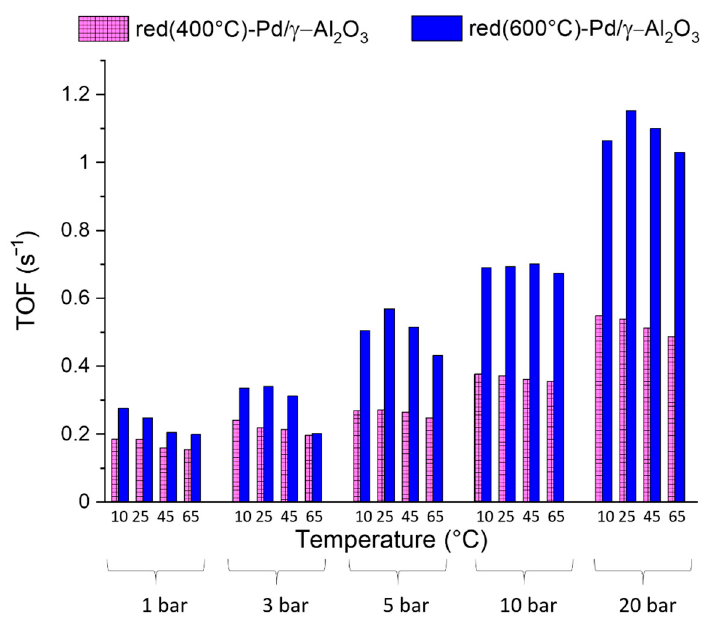
Figure 9. Effect of reaction conditions on the specific activity (TOF (s − 1 )) of red(400 °C)-Pd/ γ -Al 2 O 3 and red(600 °C)-Pd/ γ -Al 2 O 3 in 2-metyl-3-butyn-2-ol hydrogenation with 0.5 mL/min flow rate of the reactant and 6 mL/min of the H 2 flow.